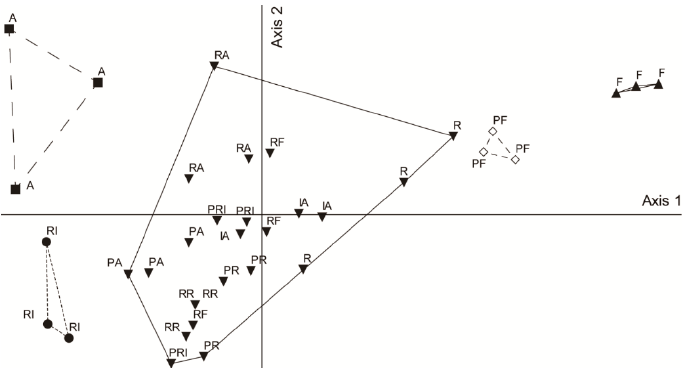
Figure 4. Detrended correspondence analysis (DCA) ordination showing former and current land-